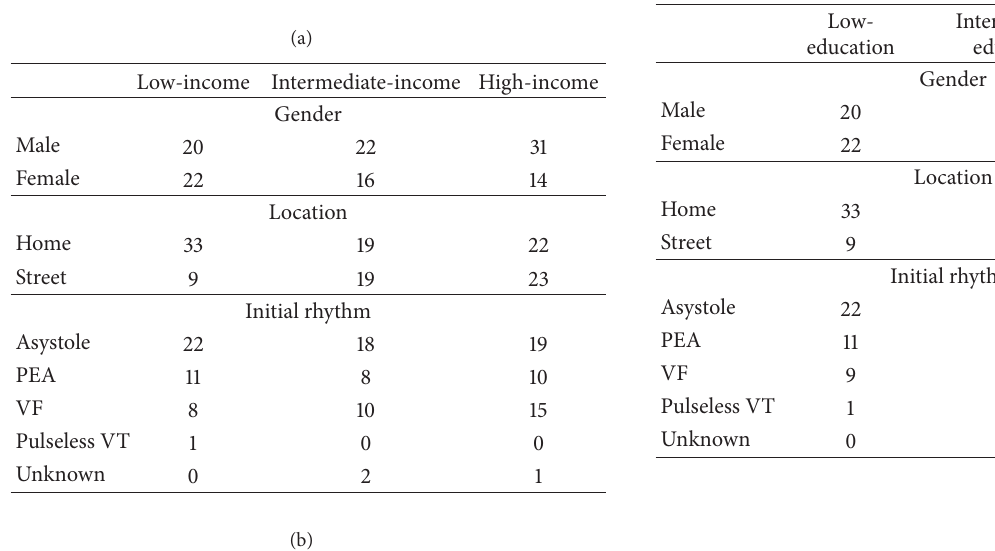
Table 1: Patient demographics and neighborhood